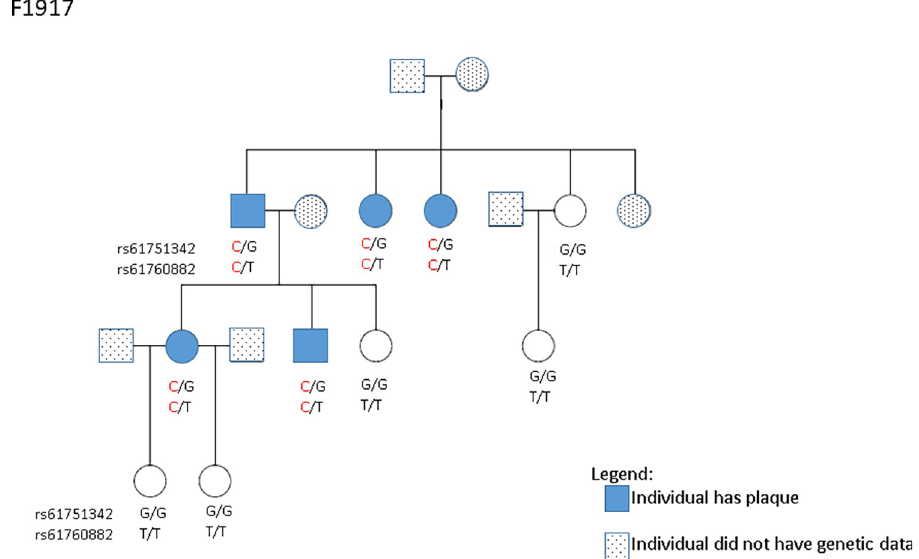
Fig 1. Genotypes for rs61751342 ( DENND2B ) and rs61760882 ( RNF141 ), two missense variants found to co- segregate with plaque presence in family